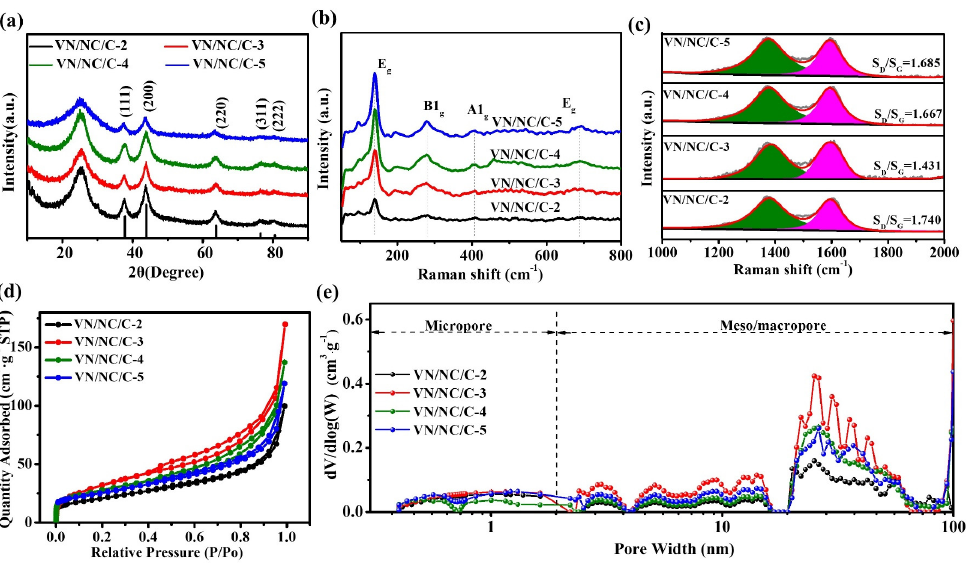
Figure 2. ( a ) XRD patterns of VN/NC/C-x. The Raman spectra of VN/NC/C-x in the range of ( b ) 50– 800 cm − 1 and ( c ) 1000–2000 cm − 1 . ( d ) N 2 adsorption − desorption isotherms and ( e ) the pore-size distribution of VN/NC/C-x.